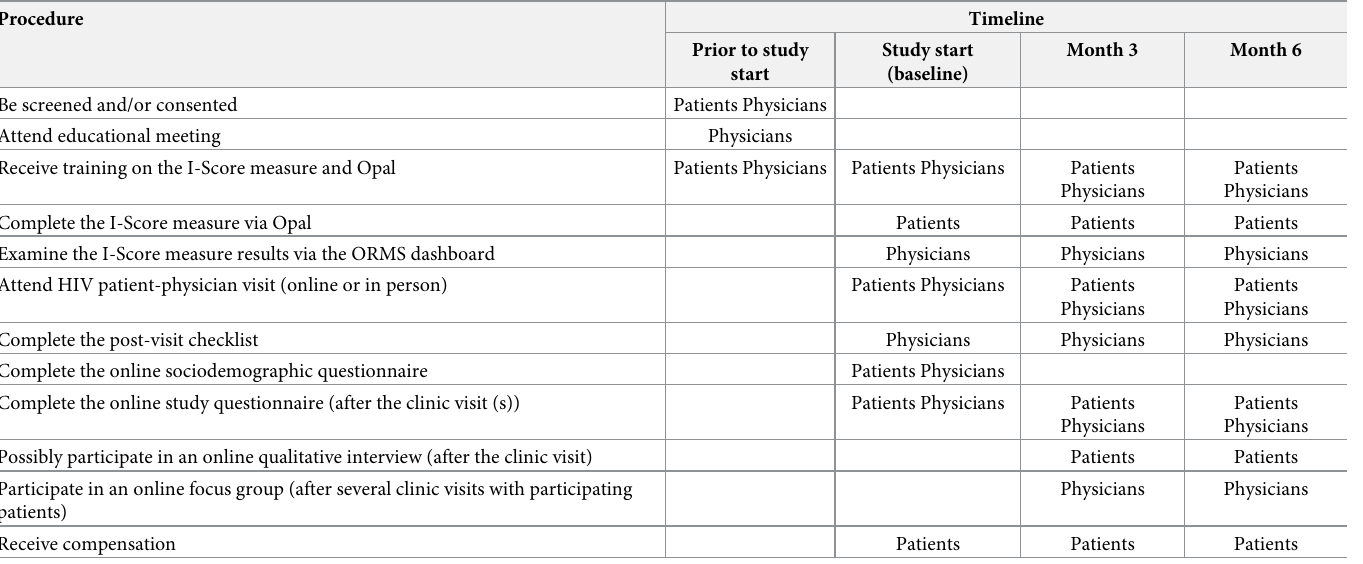
Table 1. Schedule of study procedures for